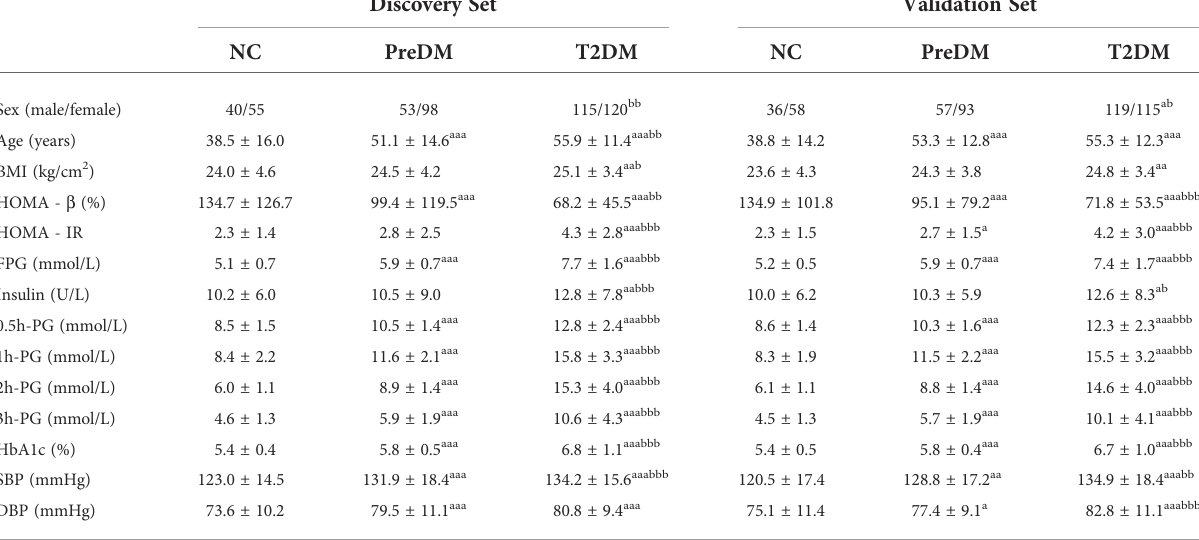
TABLE 1 Clinical characteristics of the studied subjects in the discovery and validation sets*.